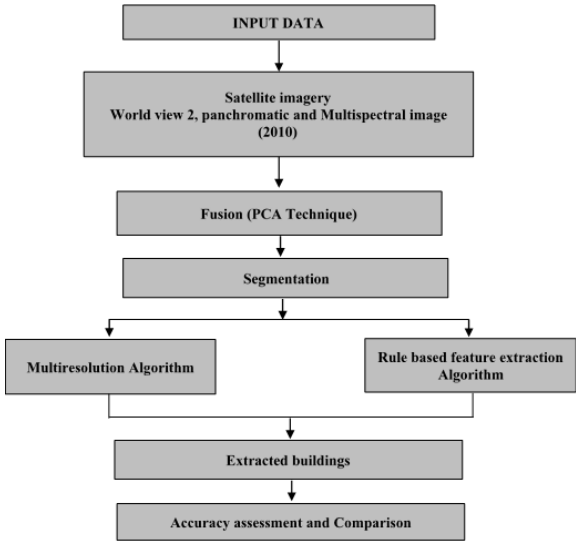
Figure 3 Methodology chart